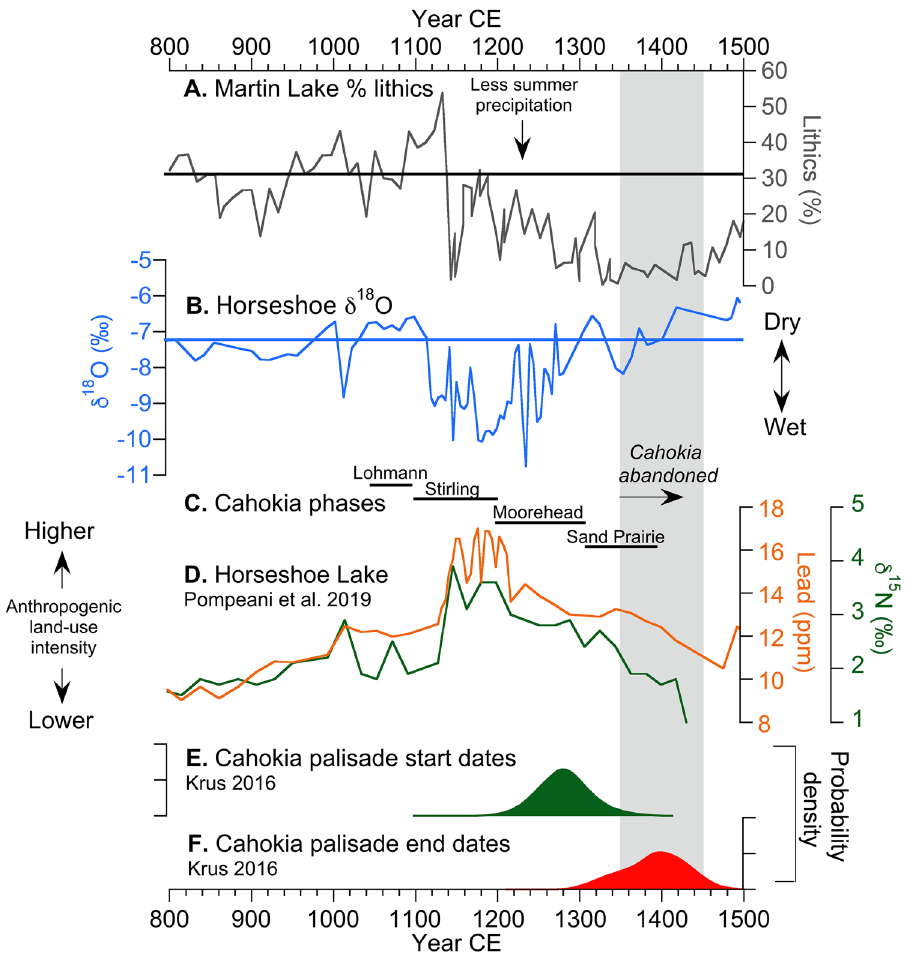
Figure 3. Proxy records from 800 to 1500 CE. ( A ) The Martin Lake % lithic record 13 . ( B ) Horseshoe Lake calcite δ 18 O data (this study). ( C ) Archaeological phases at Cahokia 38 compared against ( D ) anthropogenic disturbance proxies 20 and radiocarbon probability density functions for the ( E ) start and ( F ) end of palisade wall construction around Monks Mound 9